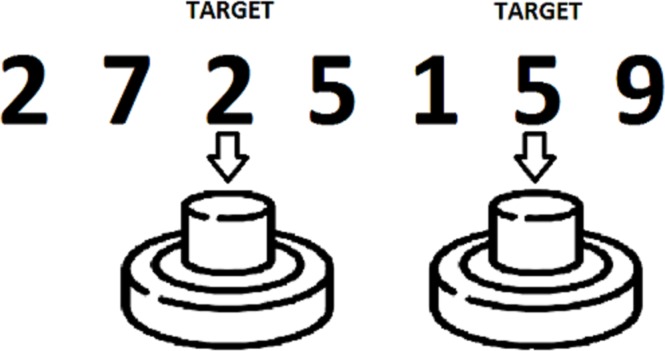
Example of a 2-back task.